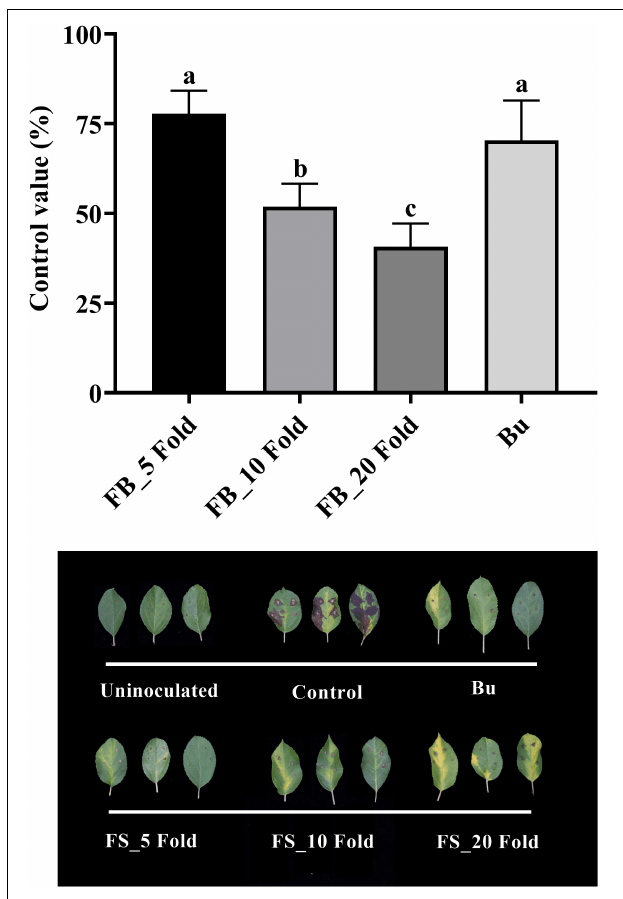
FIGURE 3 | Control efficacy of the fermentation broth of Streptomyces sp. JCK-6131 against apple fire blight in a detached leaf assay. FB = fermentation broth of Streptomyces sp. JCK-6131 and Bu = buramycin ( × 1000). Values are presented as the mean ± standard error of three runs, with three replicates each. The bars with the same letters represent non-significant differences between the treatments ( p < 0.05, Fisher’s least significant difference